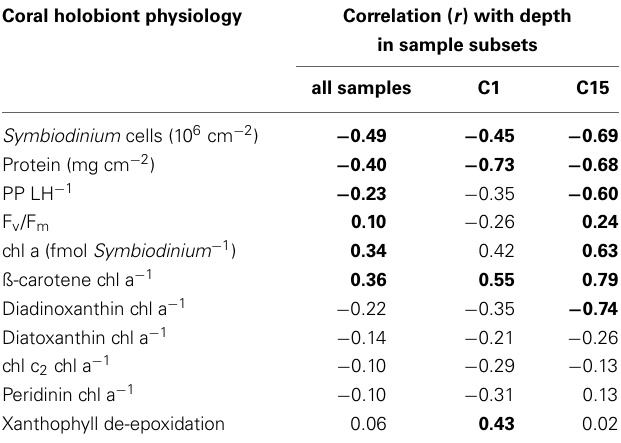
Table 1 | Correlation between physiological parameters and depth for three sets of samples: all samples ( n = 76), subset C1 ( n = 24), subset C15 ( n = 29).